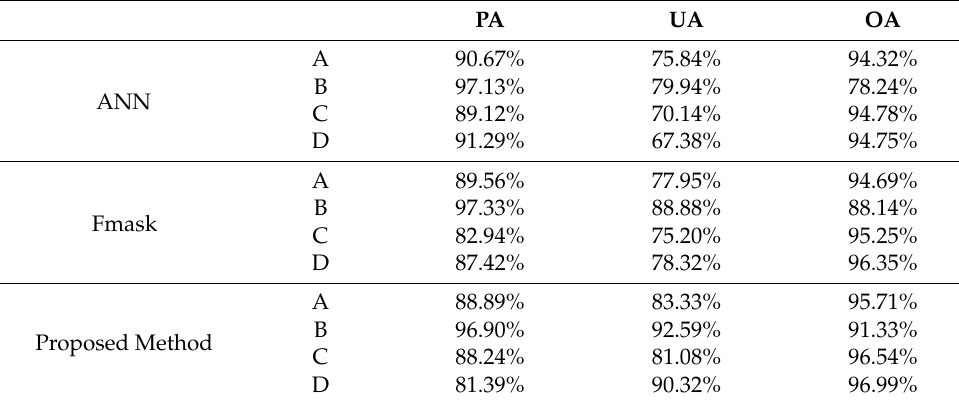
Table 7. PA, UA, and OA using the proposed method.